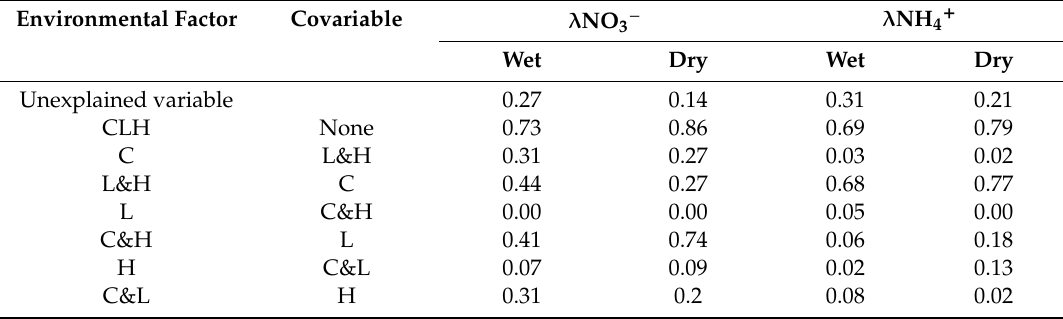
Table 2. Eigenvalues of partial RDA (pRDA) of NO 3 − and NH 4 + and separate climatic (C), landscape setting (L) and human disturbance (H) and interactive e ff ects among C, L and